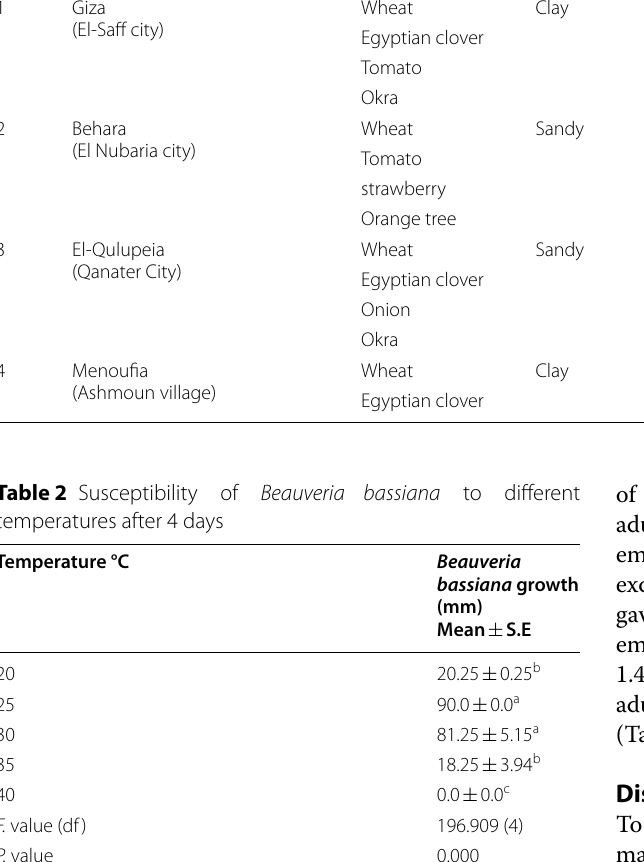
Means with different letters are significantly different at P < 0.05